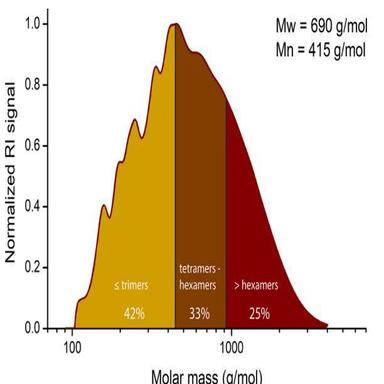
PL MW distribution as obtained by GPC (solvent: THF). Integration results of oligomeric MW ranges (≤ trimers; tetramers - hexamers; > hexamers) are highlighted.